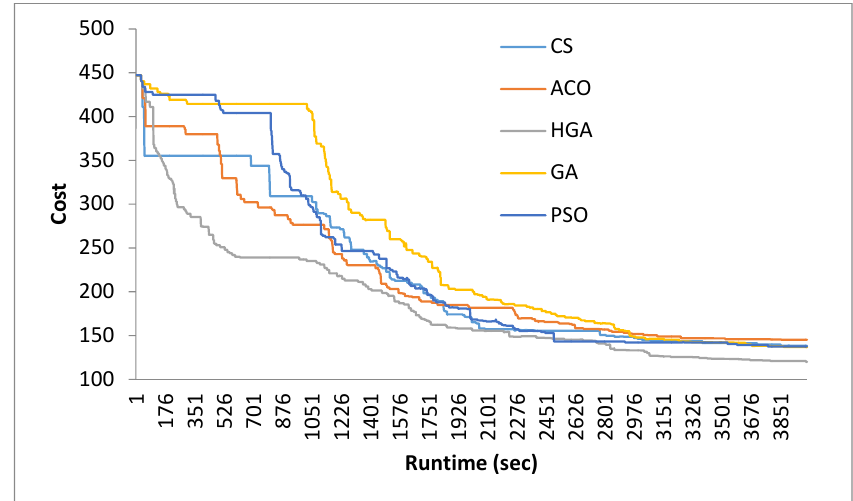
Figure 9. Plot of cost vs. runtime for 50 tasks.